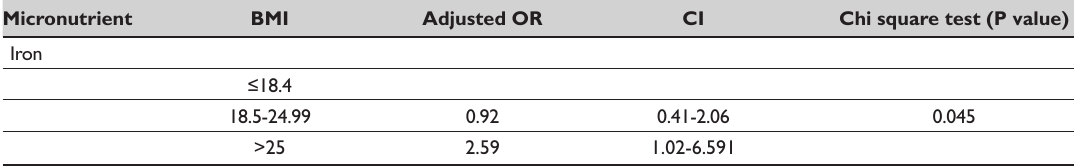
Table 3: Multivariate analysis for association of micronutrient intake by BMI among HIV+ patients initiating HAART after adjusting for duration on HAART and use of multivitamins